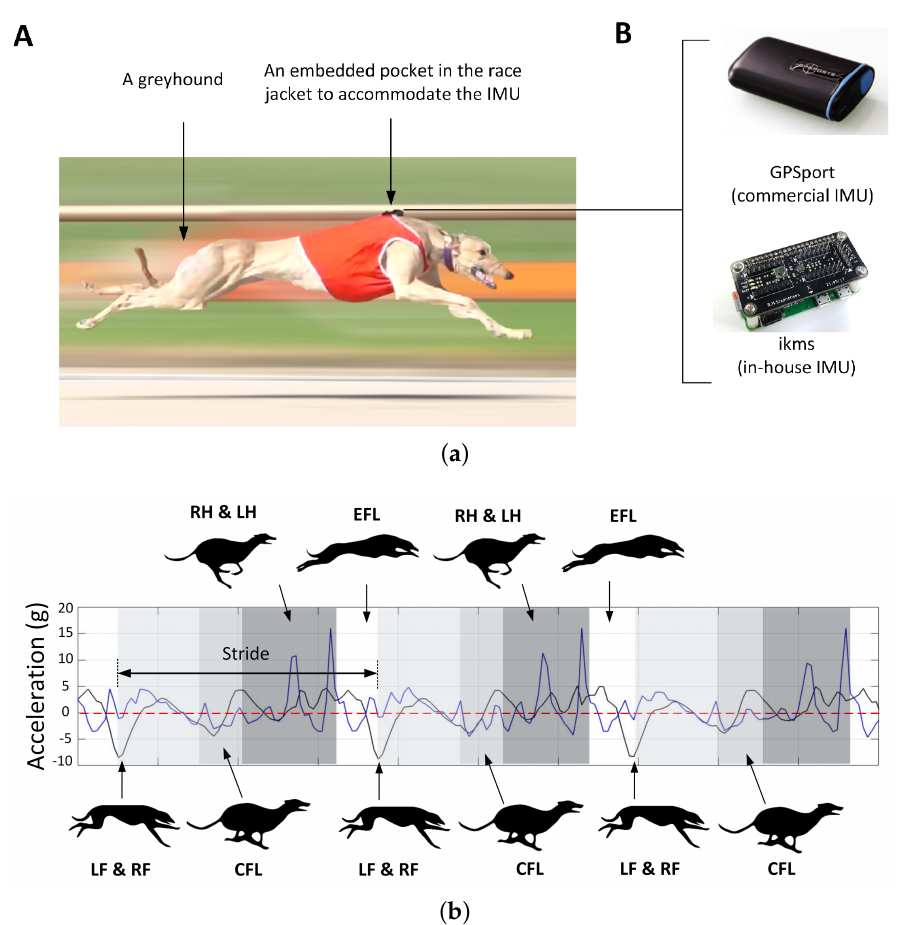
Figure 5. Accelerometry used on racing greyhounds. ( a ) ( A ) A greyhound galloping on the straight section of a track with sand surface and wearing the modified jacket with IMU pocket. ( B ) An integrated kinematic measurement system (ikms), developed in house, was used to record the acceleration signals. Data validation of the ikms was achieved using a commercial IMU (GPSport) device. ( b ) Forward (Black trace) and vertical (blue trace) acceleration vs time of three consecutive strides of a greyhound and the corresponding galloping gait events. Rotary gallop is a four-beat gait with two flight phases [41]. The limb impact in this gait moves from limb to limb in a circular pattern that is, left fore-leg (LF), right fore-leg (RF), compressed flight phase (CFL), right hind-leg (RH), left hind-leg (LH) and extended flight phase